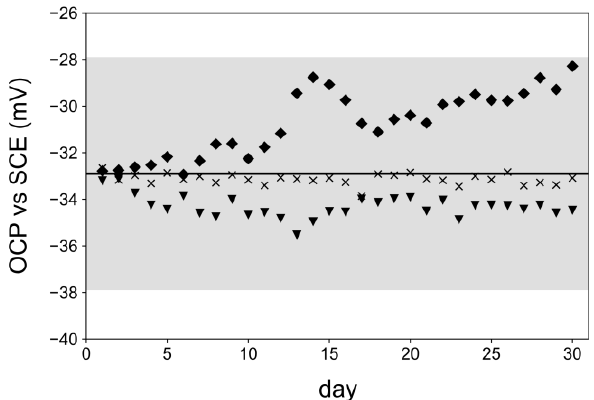
Figure 7. Long-term potential stability of 3D-RE with k = 0.95 ( n = 3) over 30 days of daily OCP vs. SCE measurements in 0.1 M KCl. Different symbols represent different fabricated 3D-REs. The black solid line corresponds to the mean starting potential, while the shaded region corresponds to the acceptable OCP drift region of ± 5 mV from the starting potential [23,51].